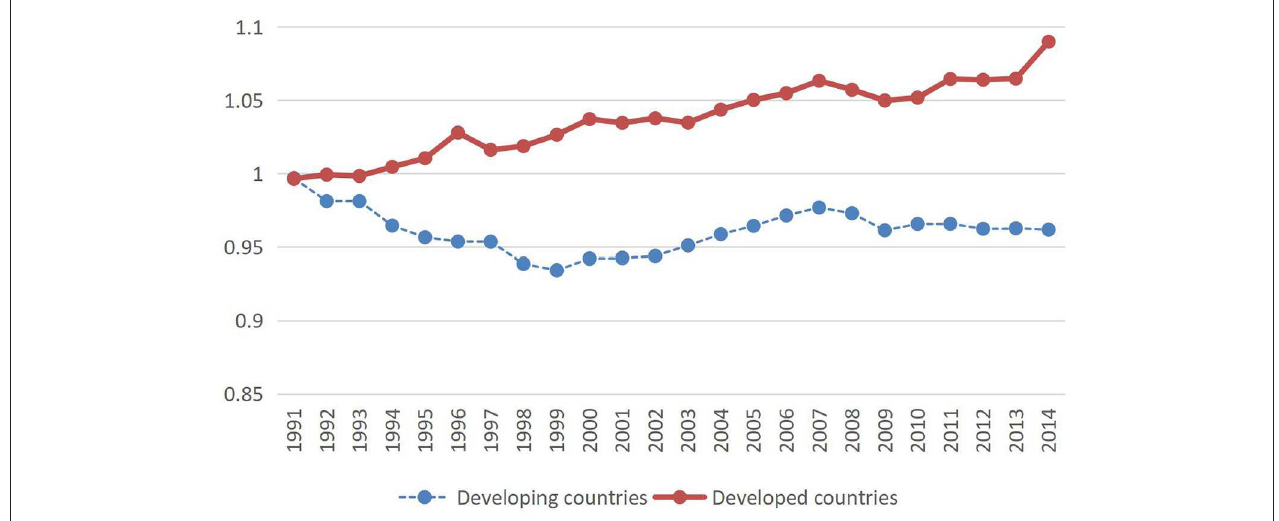
FIGURE 1 | GTFP in developed and developing